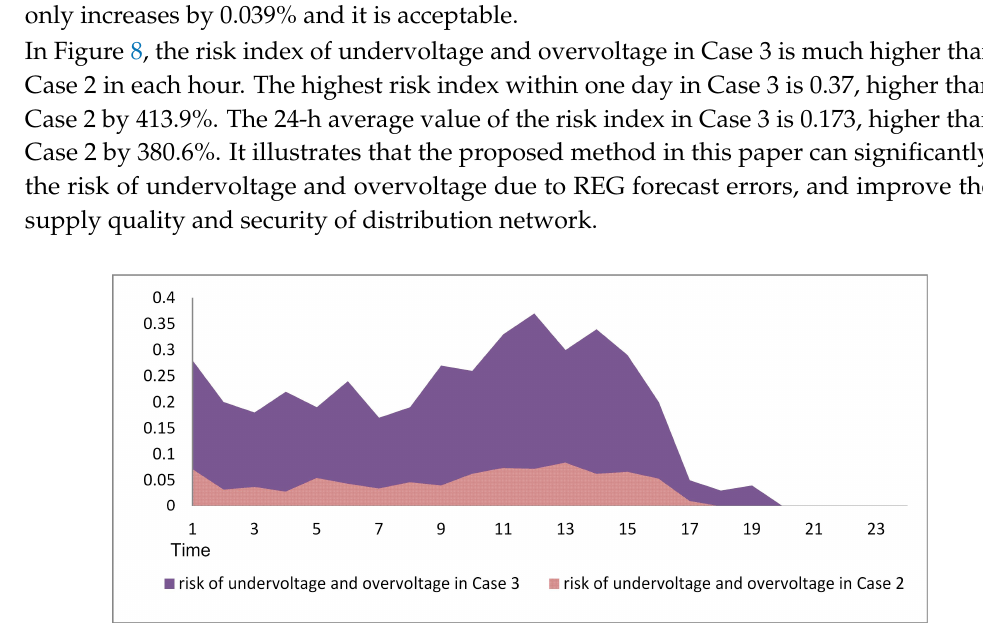
Figure 8. Risk of undervoltage and overvoltage in Case 2 and Case 3.